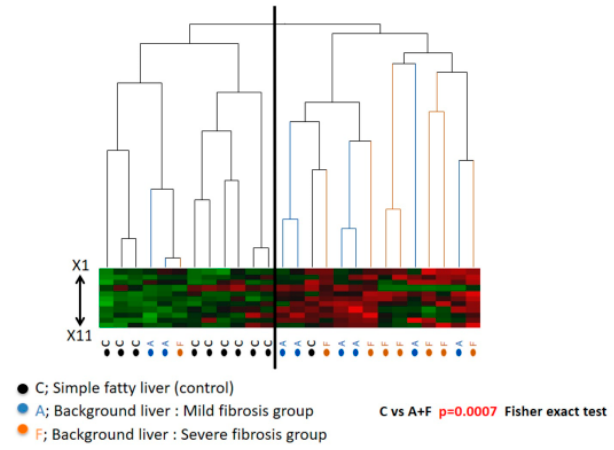
Figure 4. Hierarchical cluster analysis using methylation level. The methylation levels in the background liver of severe fibrosis and mild fibrosis were higher than those of simple fatty liver (control) ( p = 0.0007). On the other hand, the methylation levels in the background liver of severe fibrosis and mild fibrosis were similar.